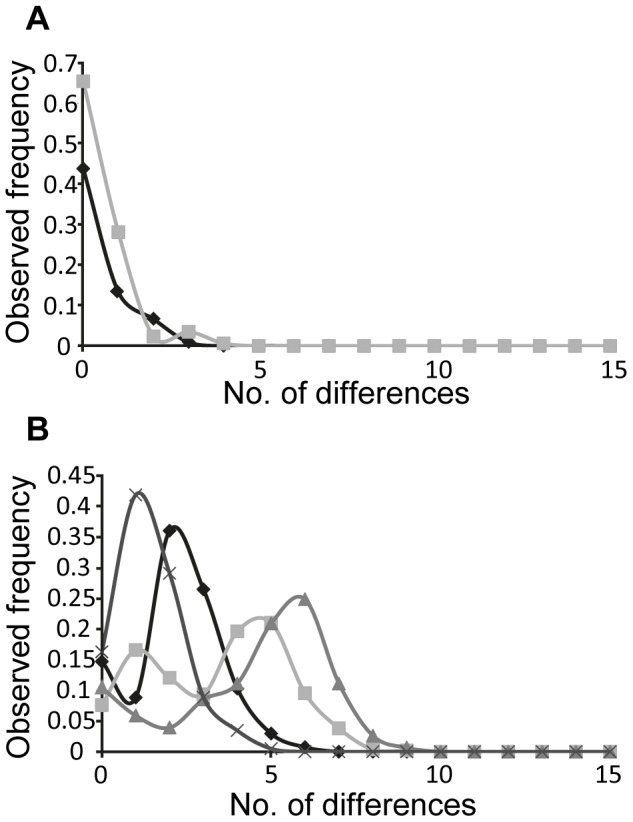
Mismatch distributions for P. superciliosus clades.(A) Mismatch distributions for gilgandra (diamonds) and superciliosus (squares) inferred using the ND3 sequences and a constant population size model. (B) Mismatch distributions for gilgandra (diamonds), superciliosus (squares), eastern phylogroup (triangles) and western phylogroup (crosses) inferred using domain I sequences and a constant population size model.